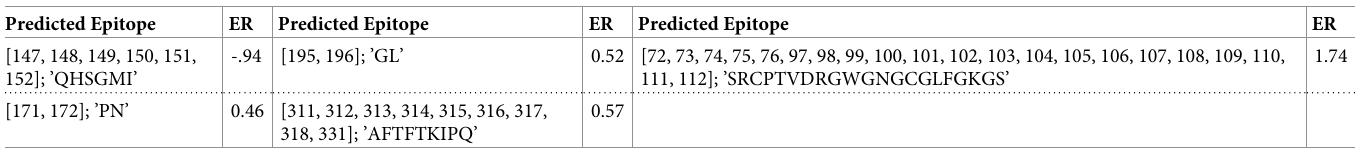
29% were associated with West Nile virus, and 0% were associated with Japanese encephalitis virus (Table 4).